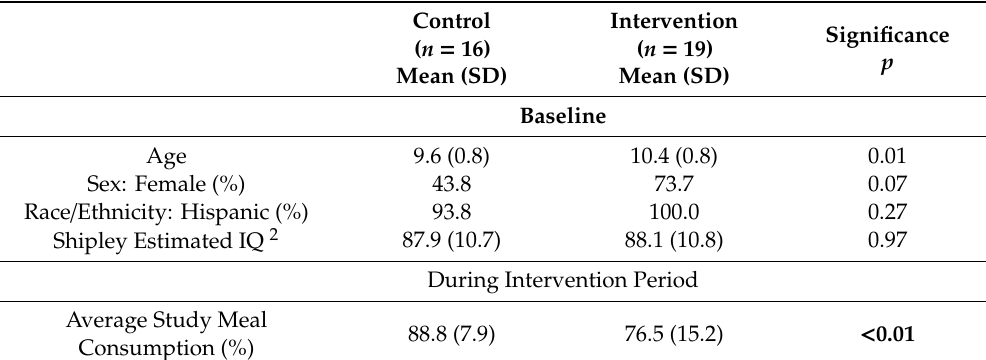
Table 1. Characteristics of Children Participating in the Feeding Trial 1